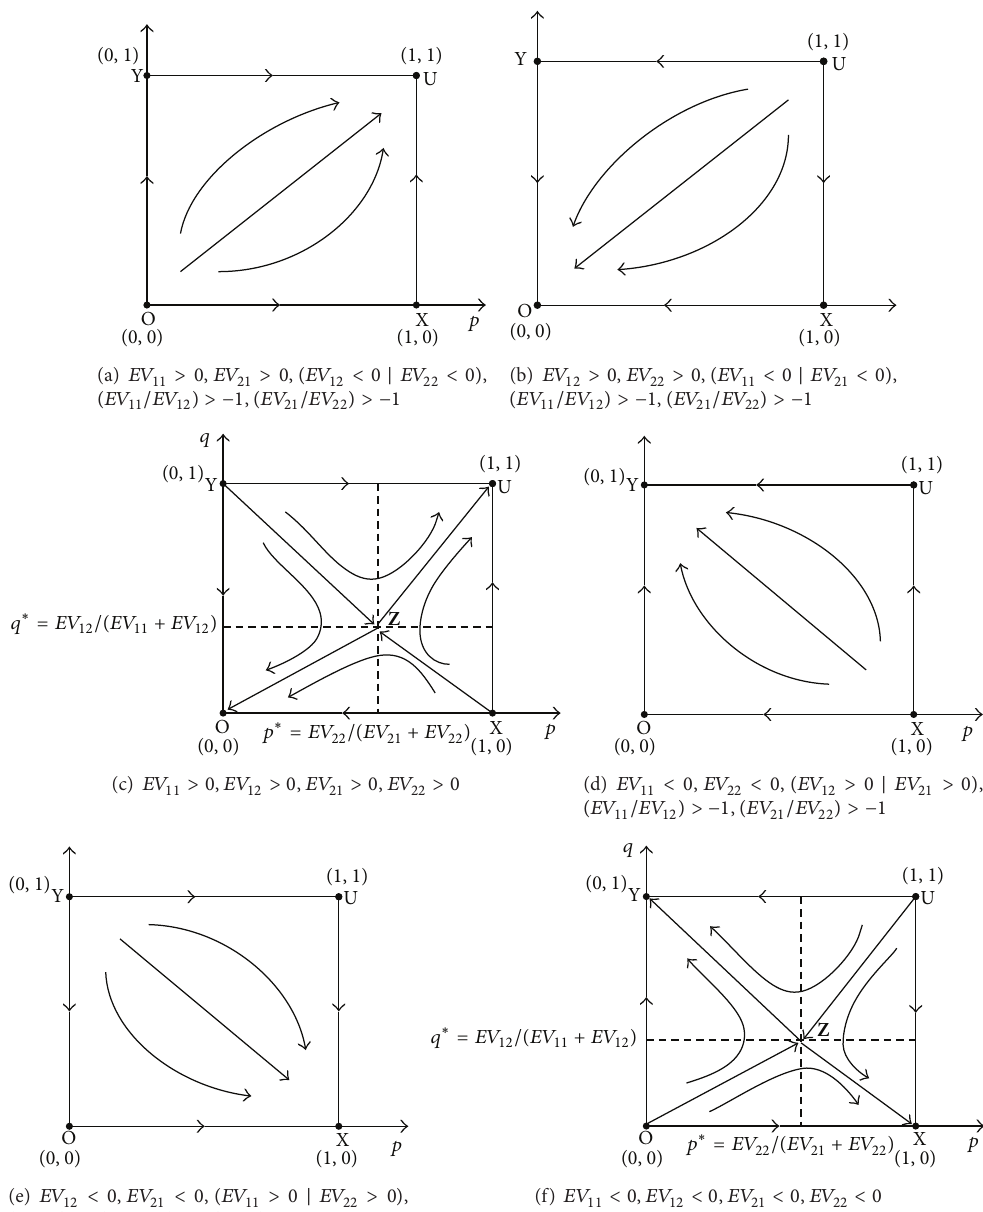
Figure 2: Replication dynamic relationship and stability of two